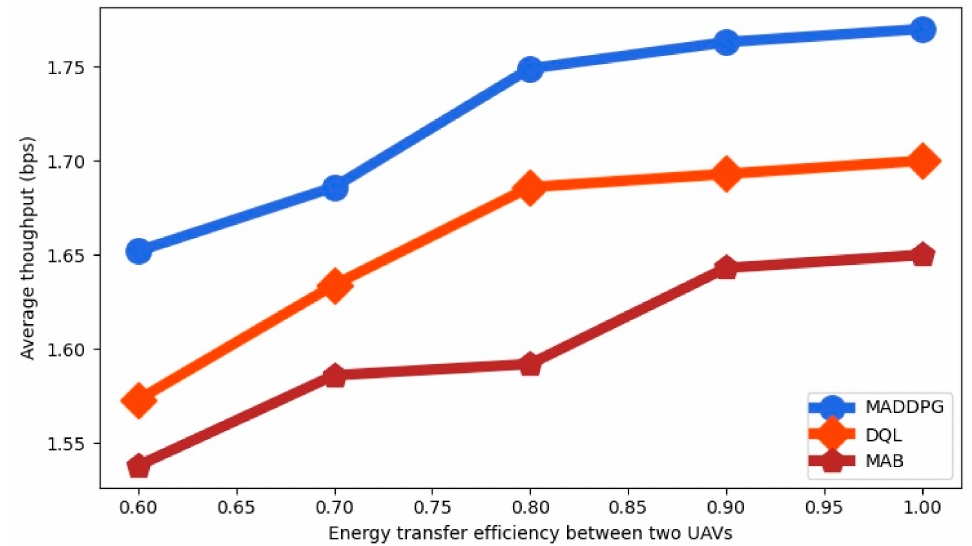
Figure 9. Average throughput as a function of the energy transfer efficiency between two UAVs. The convergence behavior of the reinforcement-based algorithms in terms of average reward is shown in Figure 10 for a network of three UAVs and 14 users. The convergence be- havior is around 1400 iterations for MADDPG. For DQL it is shorter (around 600 iterations). Finally, for MAB the convergence time is larger (around 1100